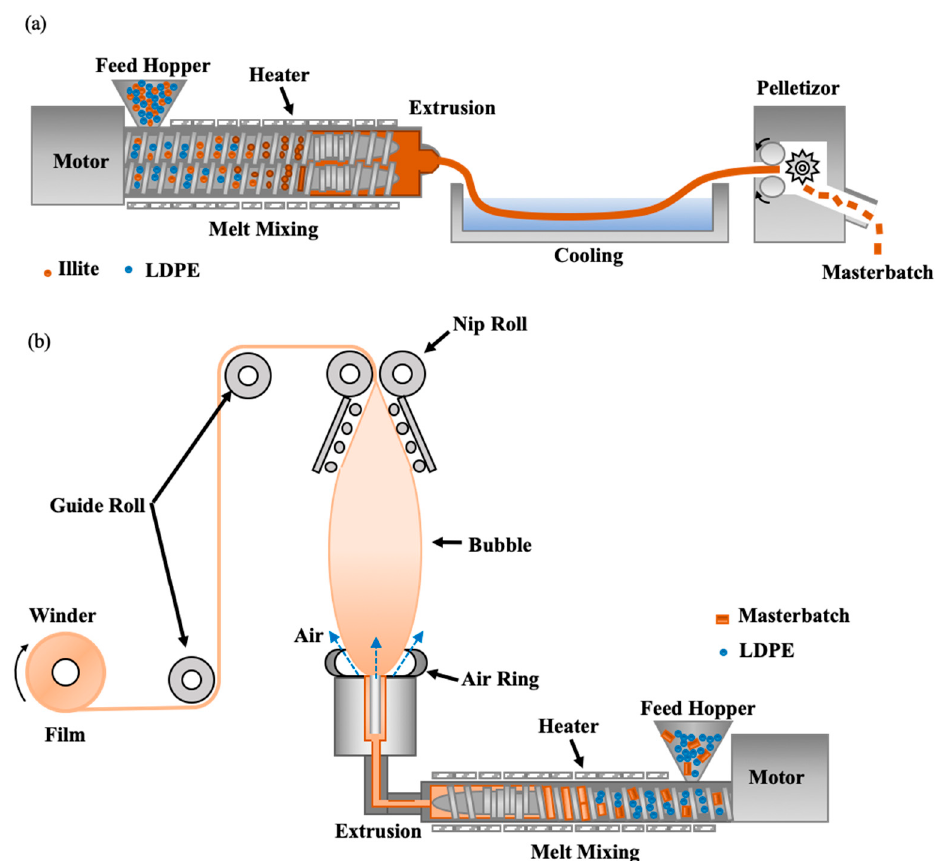
Figure 1. Schematic diagrams for preparation of ( a ) illite-PE masterbatch and ( b ) illite-PE film.